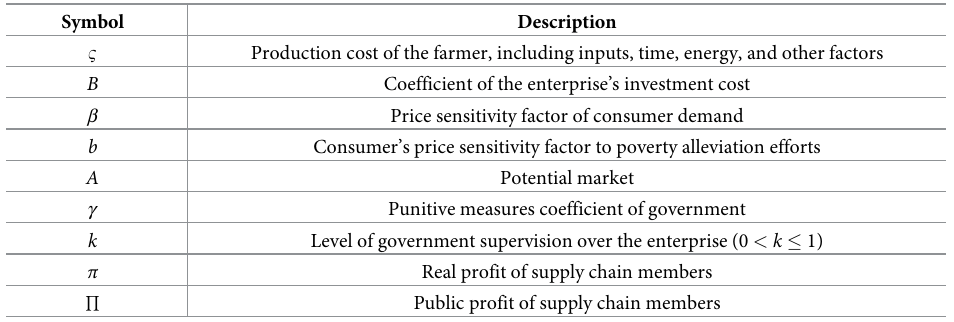
Table 1. Symbol description.